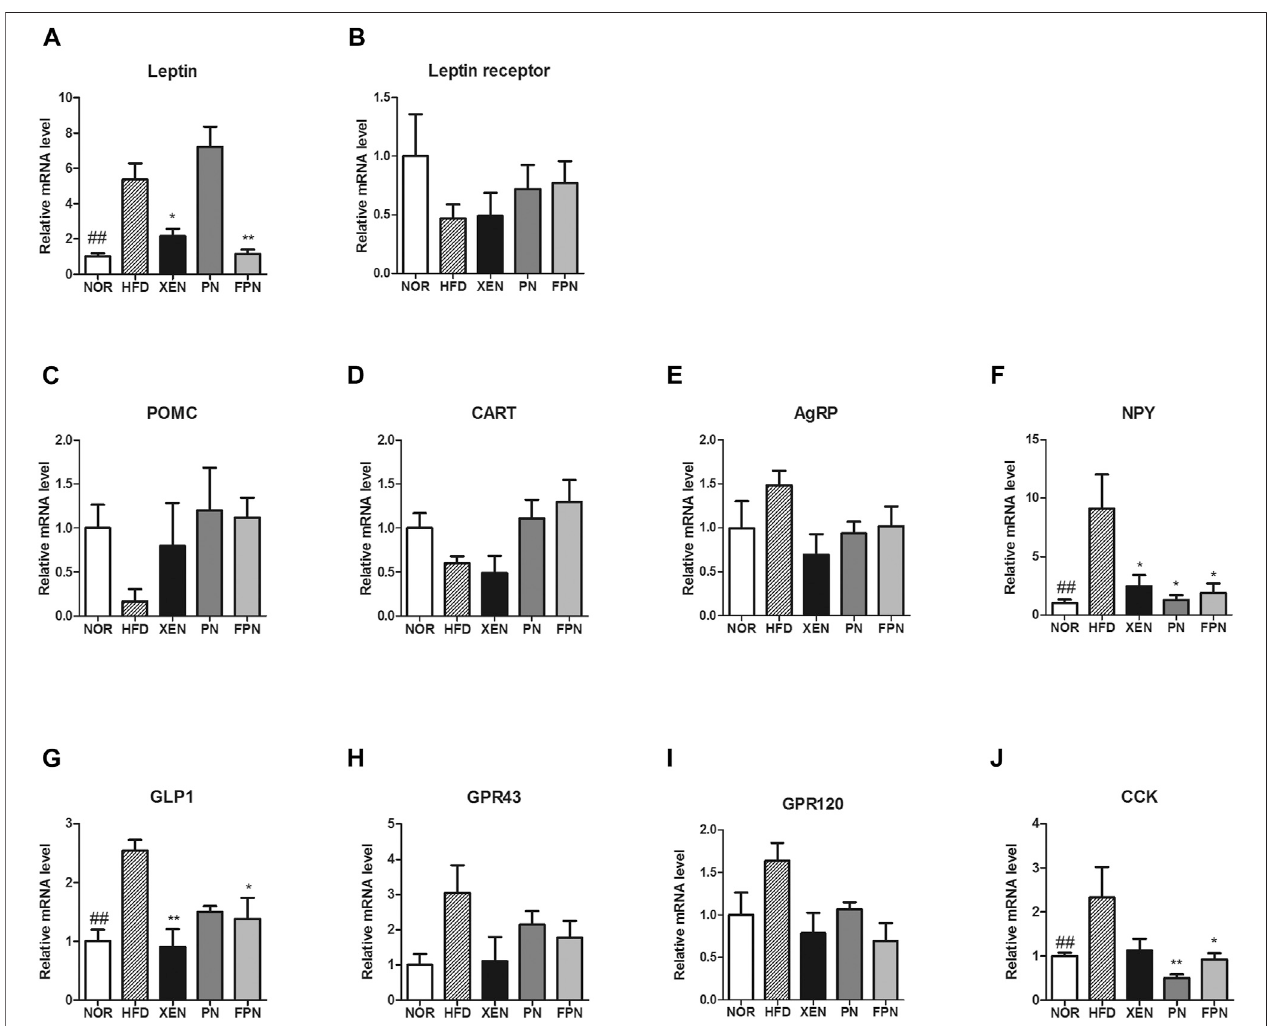
FIGURE 5 | Effect of PN and FPN on gene expressions of the satiety hormone leptin, appetite regulators, and gut hormones in HFD induced mouse model after treatment for 9 weeks. The expressions levels of the gene of interest in the hypothalamus, adipose tissue, and intestine were determined by RT-PCR. The relative gene expression of (A) leptininadiposetissuewasmeasured.Therelativegeneexpressionsofappetiteregulators (B) leptinreceptor (C) POMC, (D) CART, (E) AgRP,and (F) NPY in the hypothalamus was determined. The relative gene expression of gut hormones (G) GLP1, (H) CPR43, (I) GPR 120, and (J) CCK in the colon was measured. The data are expressed as the mean ± SEM ( n (cid:2) 7 – 8); ## p < 0.005; NOR vs. HFD group. * p < 0.05; ** p < 0.01; HFD group vs. treatment groups (XEN, PN and